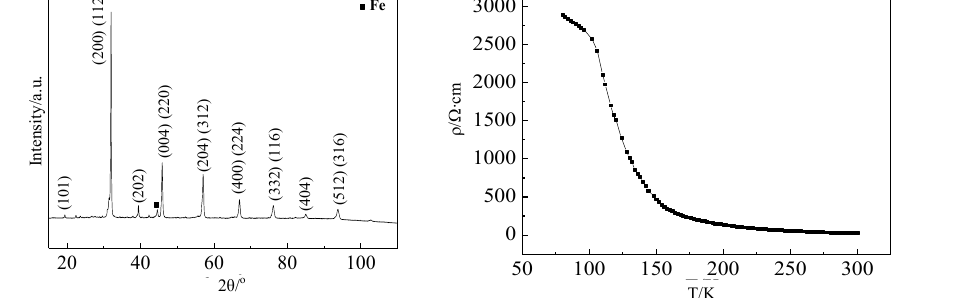
Figure 1. XRD pattern of Sr